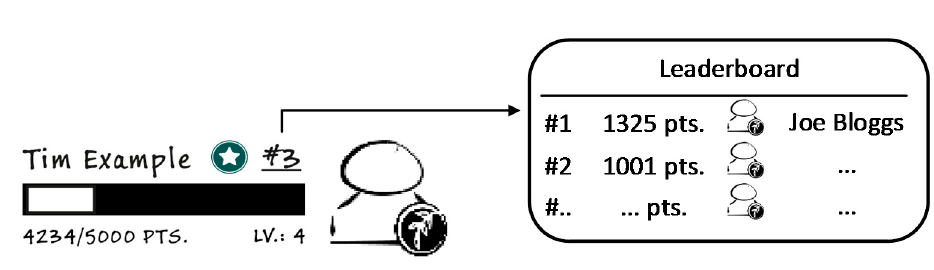
Figure A3. User platform–Leaderboard based on gamification.